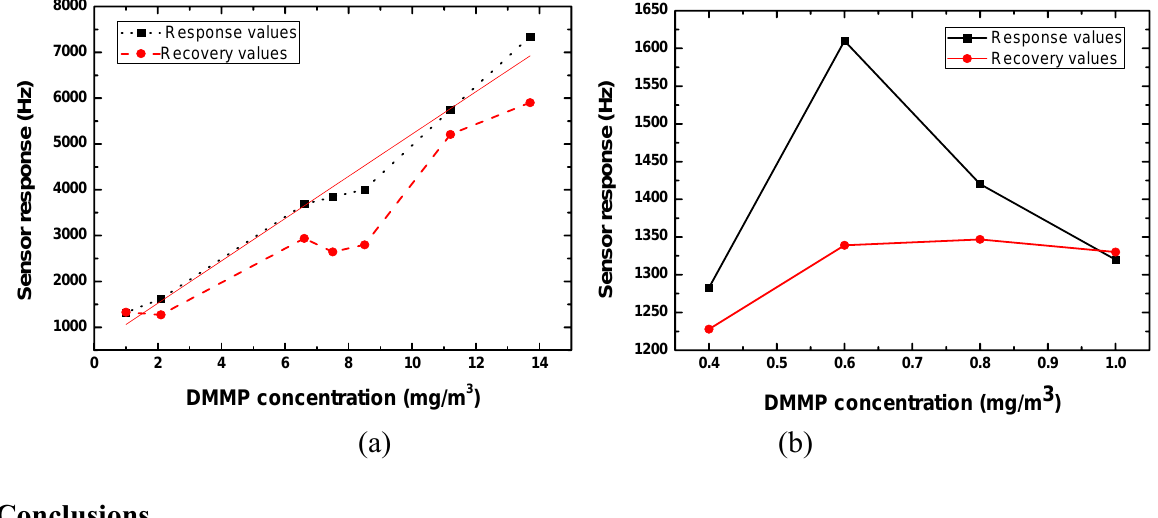
Figure 11. Sensor responses in terms of vapor concentration at (a) high, and (b) low DMMP